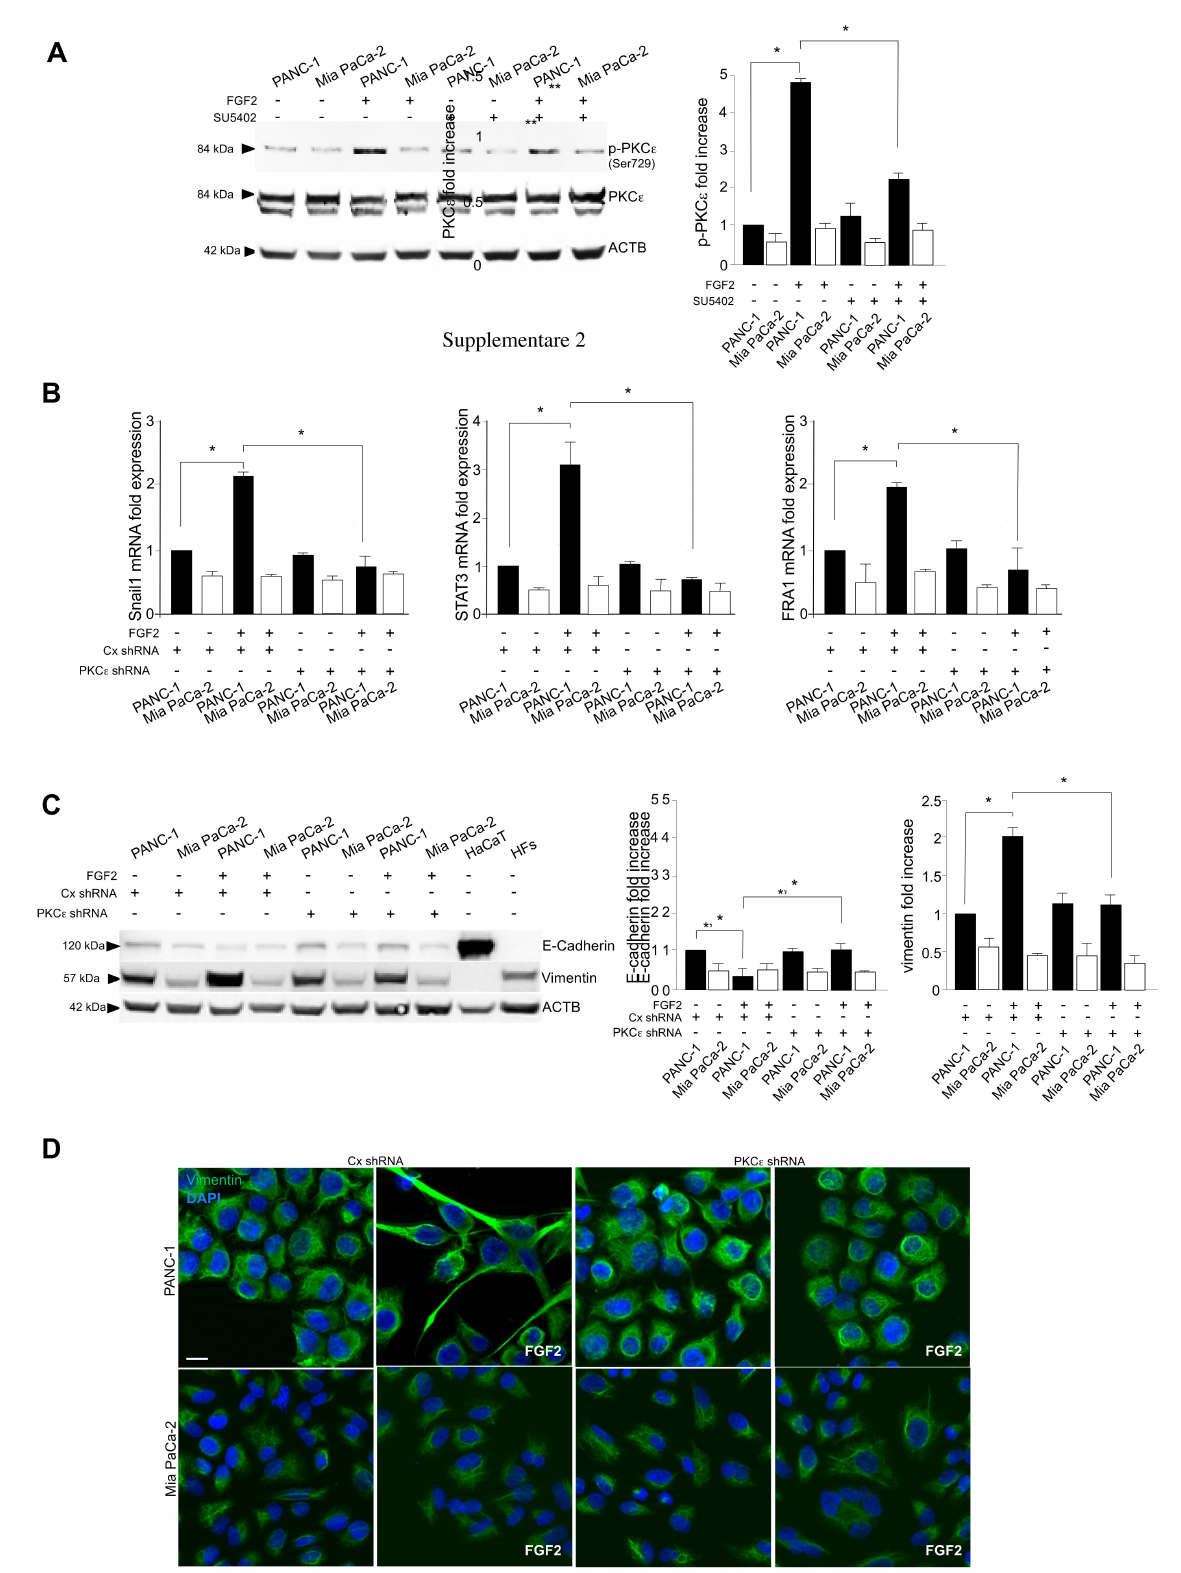
Figure 4. The depletion of PKC ε interferes with FGF2 − triggered EMT phenotype. PANC − 1 and Mia PaCa − 2 cells were left untransduced or stably transduced with PKC ε shRNA or with an unrelated shRNA, as negative control. Cells were left untreated or stimulated with FGF2 in presence or absence of SU5402 as above. HaCaT cells and HFs were used as positive controls for epithelial/mesenchymal marker expression, as reported above. ( A ) Western blot analysis shows that the